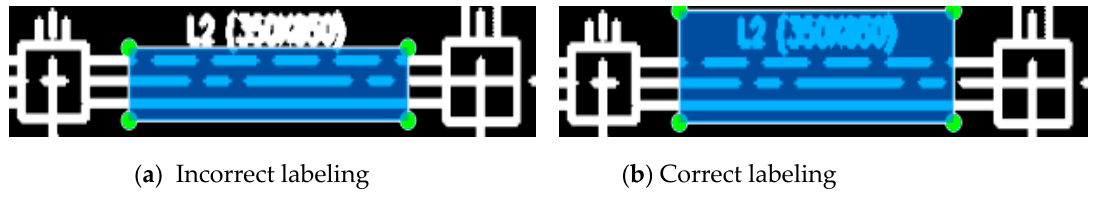
Figure 5. Labeling components in the image of structural drawings.